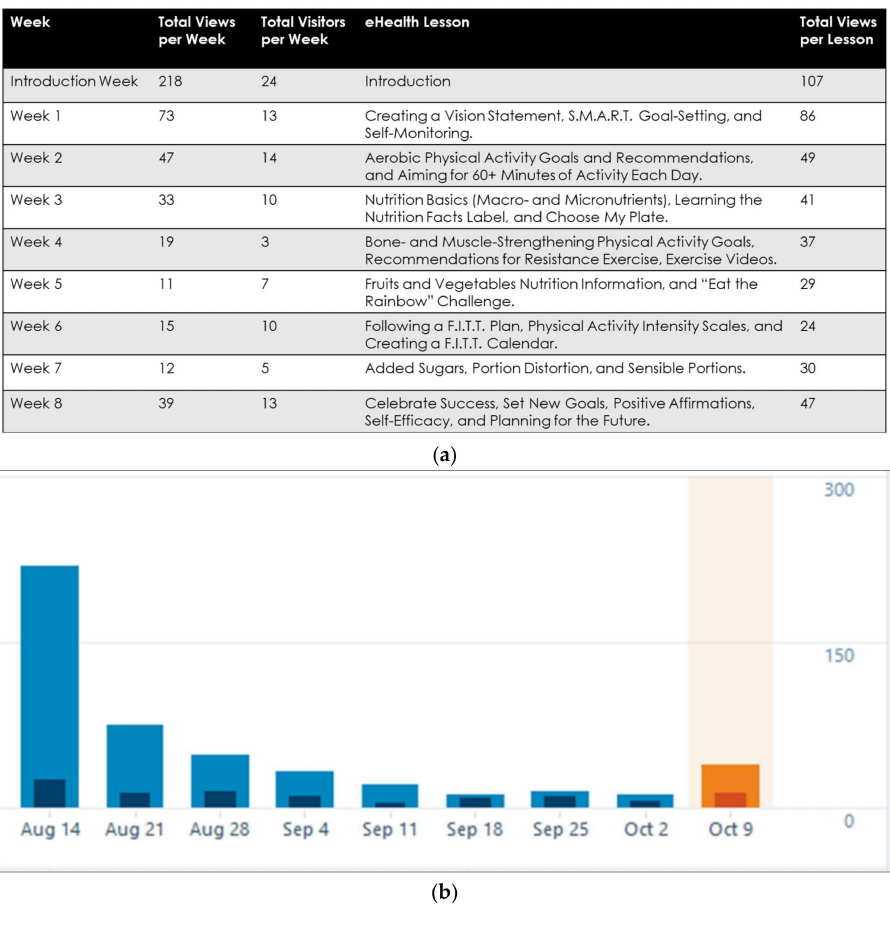
Figure 3. Overview of the eHealth program weekly lessons and webpage traffic: ( a ) total weekly views and visitors to the eHealth program peaked within the first few weeks; S.M.A.R.T. Goal-Setting denotes specific, measurable, attainable, realistic, and time-bound goals; F.I.T.T. Plan denotes frequency, intensity, type, and time chosen by the camper for physical activity participation ( b ) viewership and participation in the eHealth program peaked in the introductory week and dropped to a plateau throughout the eight-week curriculum; transparent bars represent total weekly views and opaque bars represent total weekly webpage visitors (the orange bar represents the final week of the eHealth